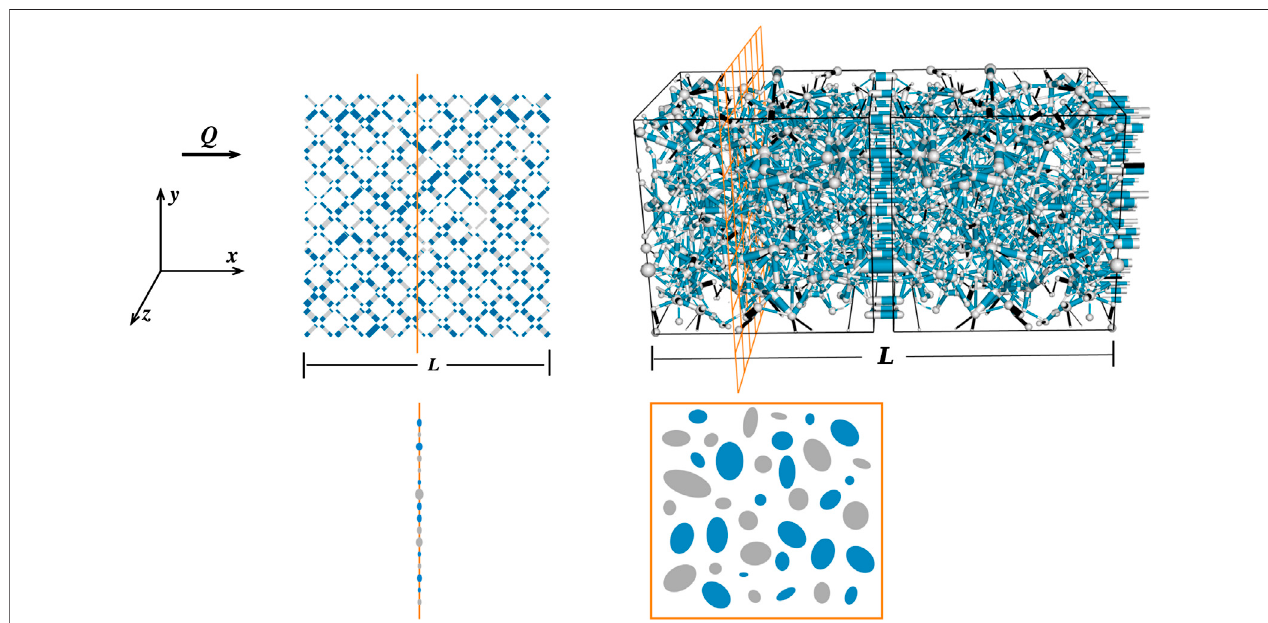
FIGURE 12 | Description of the system to measure the fl ow rates ( Q , Q w , Q n ), the pore areas ( A , A w , A n ) and the seepage velocities ( v , v w , v n ) for the 2D and 3D networks. The global pressure drop Δ P is applied in the x direction which is the direction of overall fl ow. A random cross section of the system normal to the direction of overall fl owisshown bytheorangelinefor2Dand bytheorange gridplanefor3D.Thenormalviewofthecrosssections areshownunderneathwhere thegrayandblue patchesshowtheoccupationbywettingandnon-wetting fl uidsinthecrosssection. Thetotalgrayandblueareascorrespondtothewettingandnon-wettingpore areasrespectivelyandthesumofthemcorrespondtothetotalporeareaalongthiscrosssection.Theaveragesoftheseareasoverallthepossiblecrosssectionsleadto the measurement of A , A w and A n . In this fi gure, the gray and blue patches shown in the normal view of the cross sections do not re fl ect the actual occupations of the fl uids in the above networks and are given as illustration purpose only.